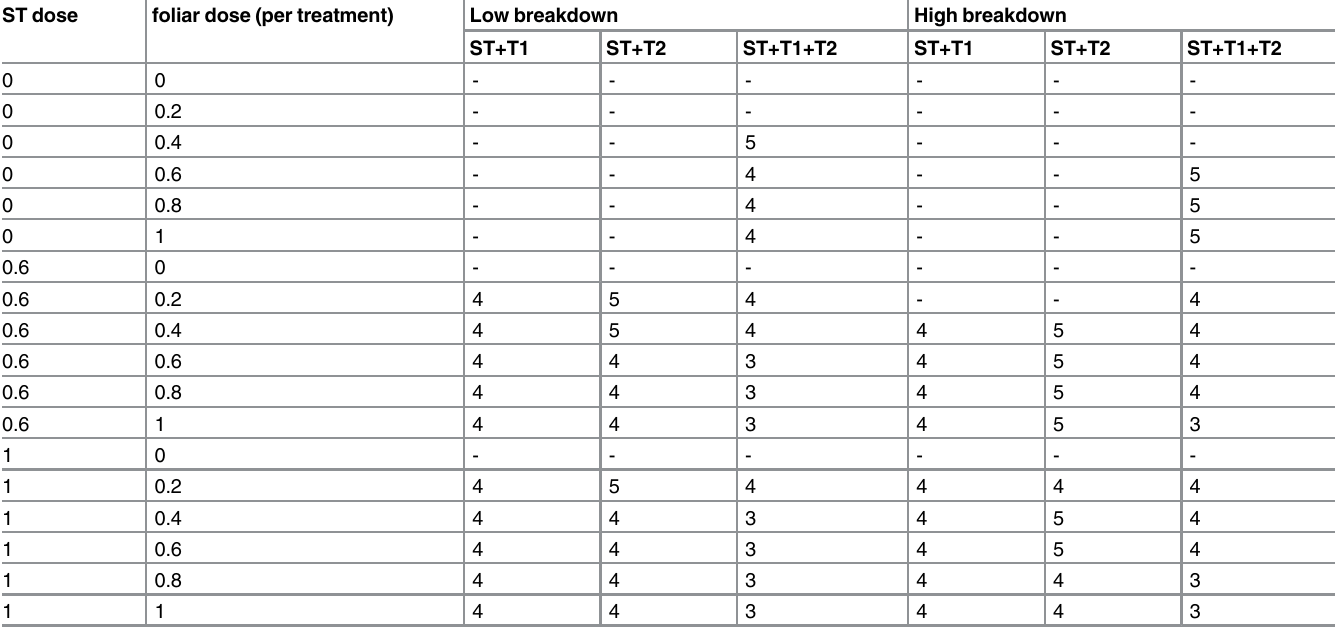
Table 2. Effective lives in the presence of low and high fungicide breakdown rates. ST dose foliar dose (per